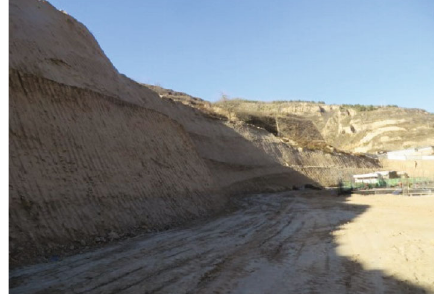
Figure 1: The unstable